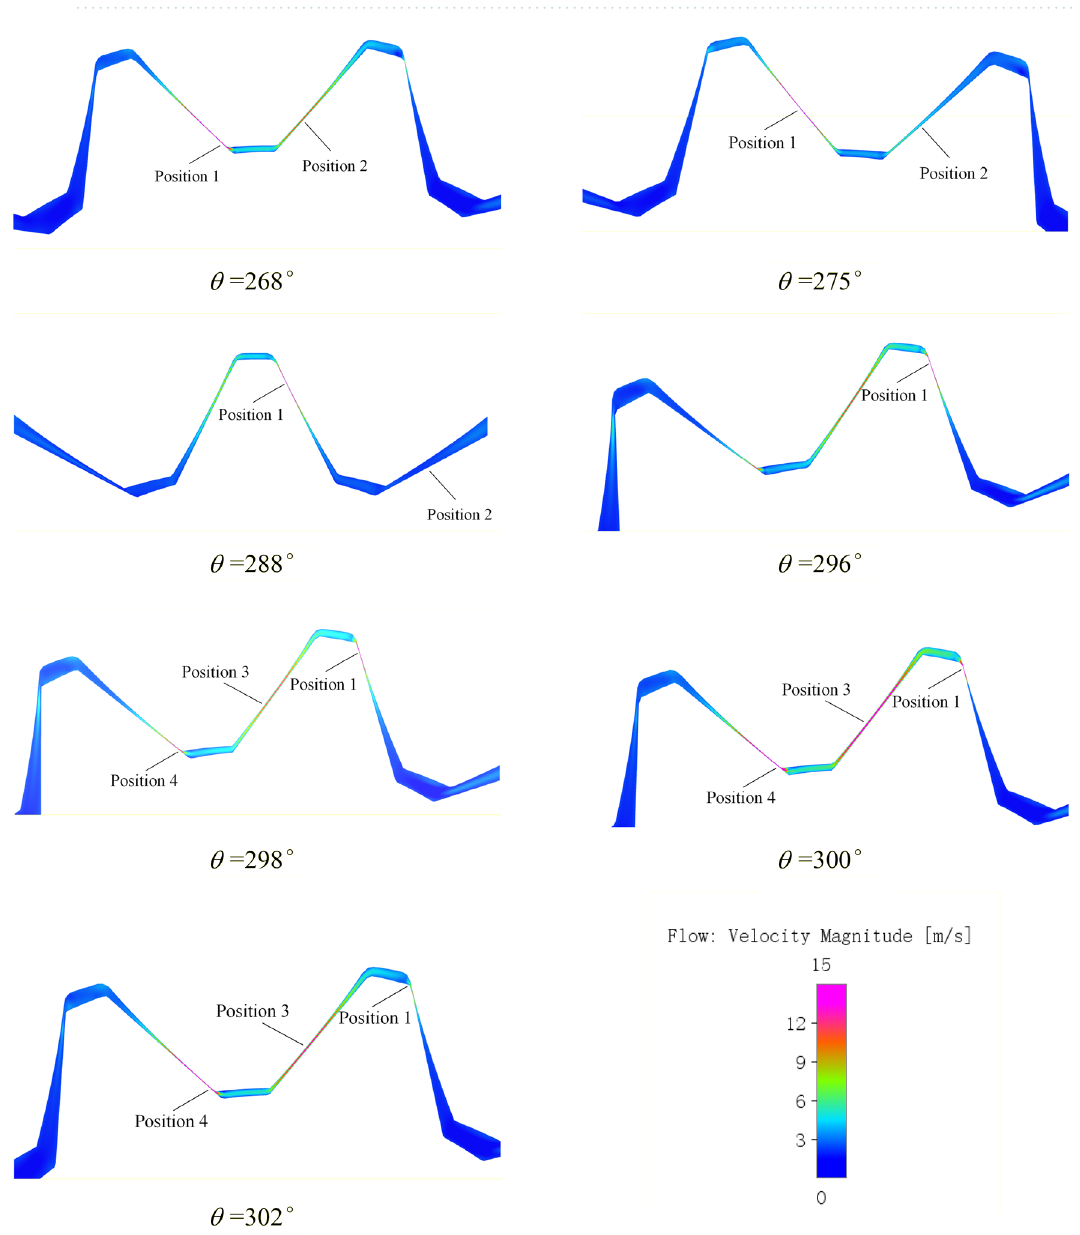
Figure 17. Velocity field in a meshing cycle of the monitoring